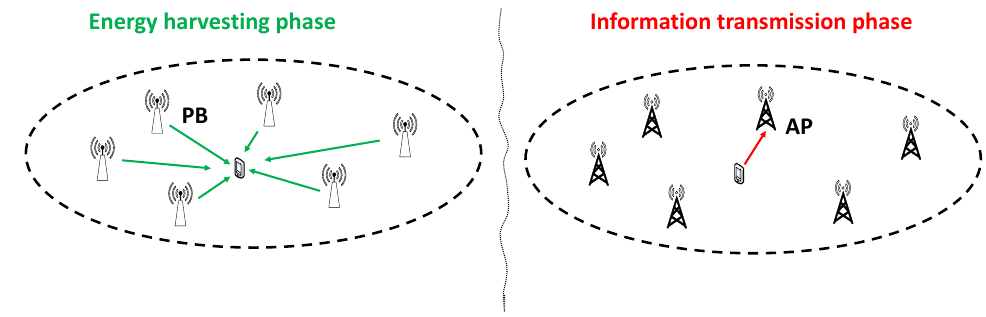
Figure 2. Time splitting in ultra-dense